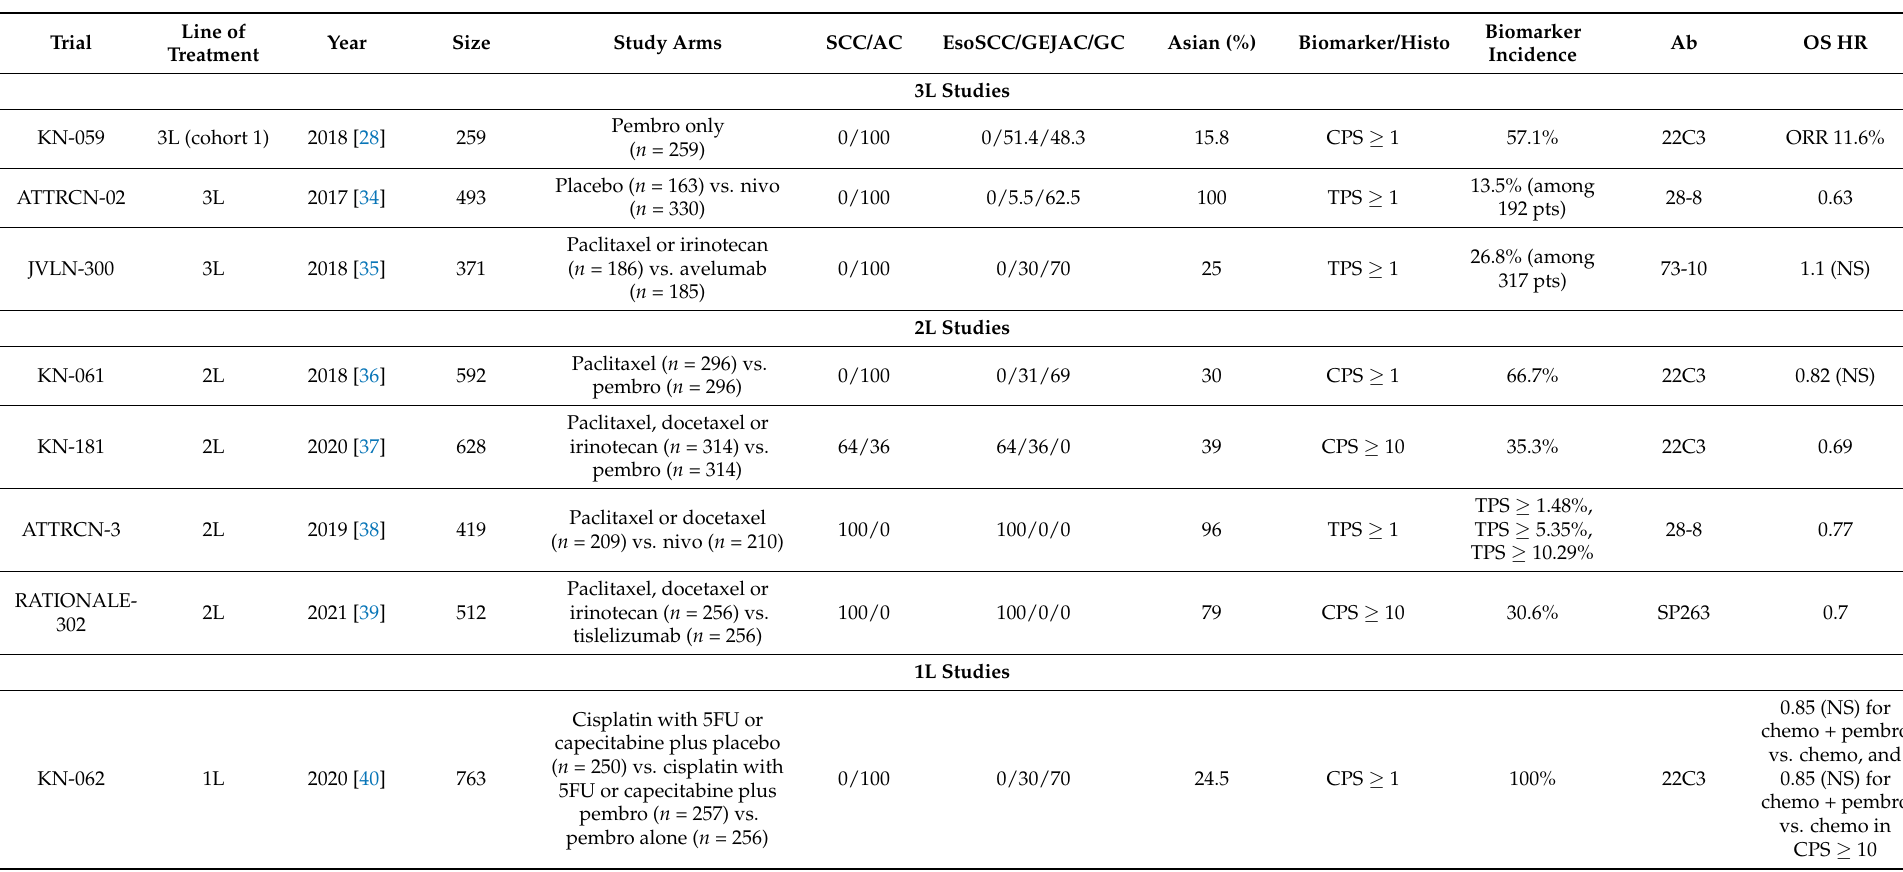
Table 1. Summarization of the trials evaluating the safety and efficacy of immune-checkpoint inhibitors for the treatment of gastro-esophageal carcinoma in different settings. Details of chemotherapy regimen, immune-checkpoint inhibitor and absence/presence of a placebo and number of patients in each arm is provided in the column designated as study arms. (KN: KEYNOTE; CM: CHECKMATE; ATTRCN: ATTRACTION; JVLN: JAVELIN; 1L: first-line; 2L: second-line; 3L: third-line; SCC: squamous cell carcinoma; EsoSCC: esophageal squamous cell carcinoma; GEJAC: Gastro-esophageal junction adenocarcinoma; GC: gastric cancer; Ab: antibody; OS: overall survival; HR: hazard ratio; CPS: combined positive score; TPS: